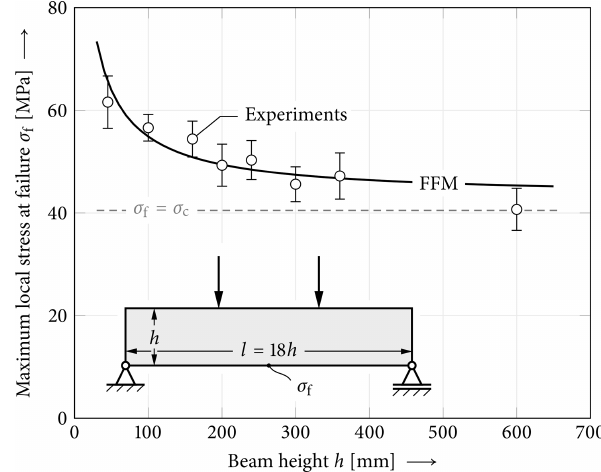
Figure 1. Size effect of wood beams in 299 self-similar four-point bending experiments. Experimental results reported by Fonselius (1997) are given as mean and standard deviation. The out-of-plane width of the beams is always b = 45mm. The strength-of-materials solution (dashed) and finite fracture mechanics (FFM) predictions (solid) are